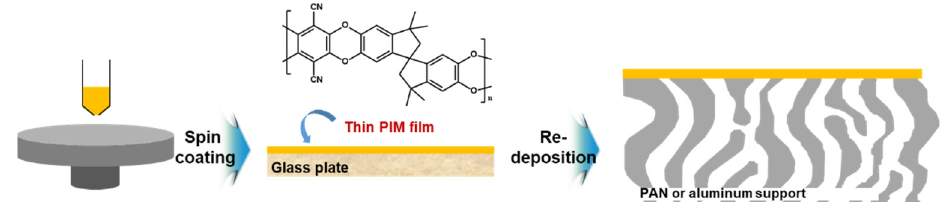
Membranes 2021 , 11 , x FOR PEER REVIEW Figure 5. PIM-based ultra-thin films with high free volume donated from its interconnected intermolecular voids.